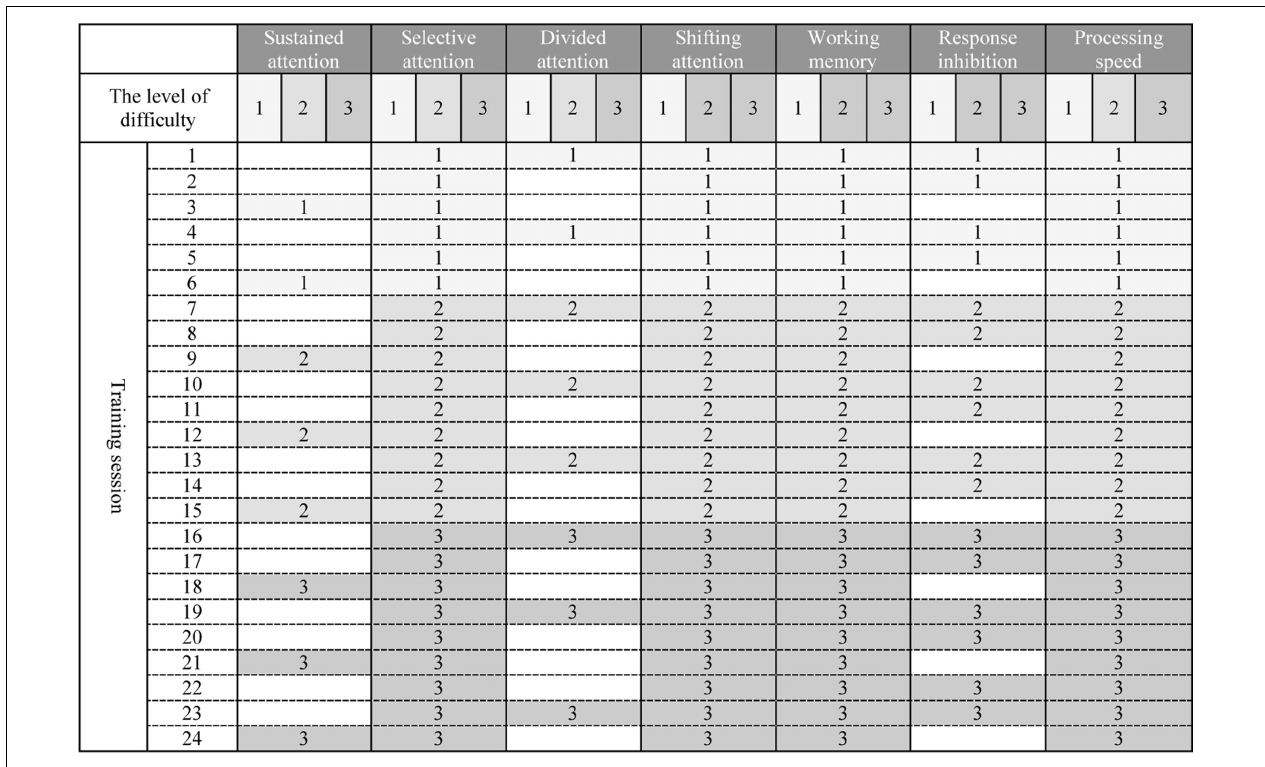
FIGURE 1 | (Architecture) Graded schedule of computerized cognitive rehabilitation exercises for 24 sessions with Maghzineh R (cid:13) . Numbers indicate the level of difficulty of each session exercises (1 = the easiest level to 3 = the hardest